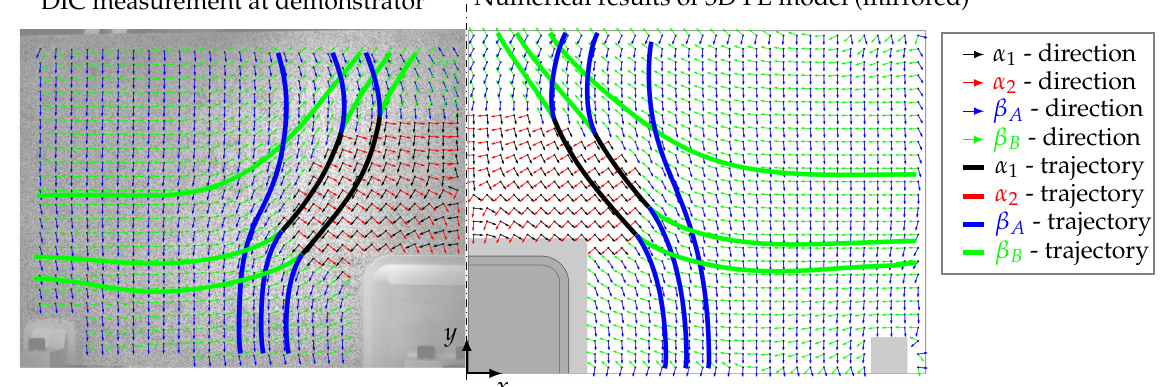
Figure 12. Comparison of the strain directions and trajectories for the experiment and simulation at an applied load of F =